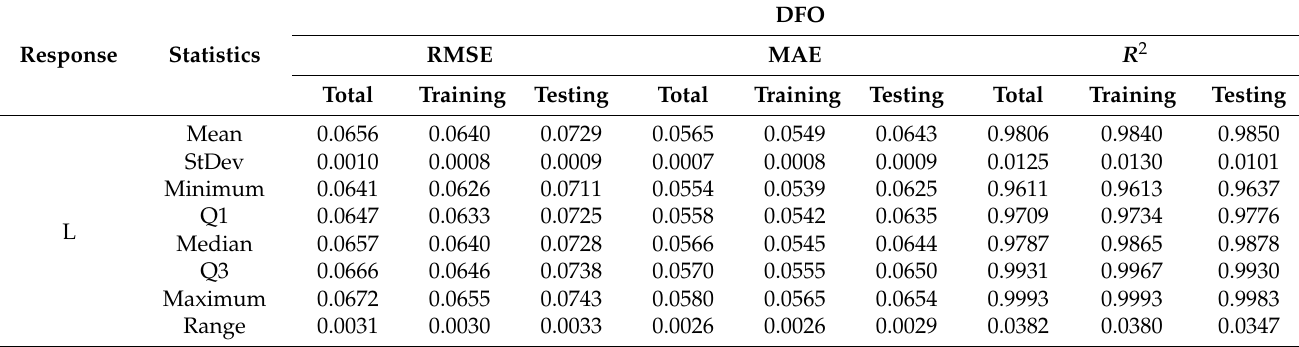
Table 12. Statistical analysis of output obtained by the DFO